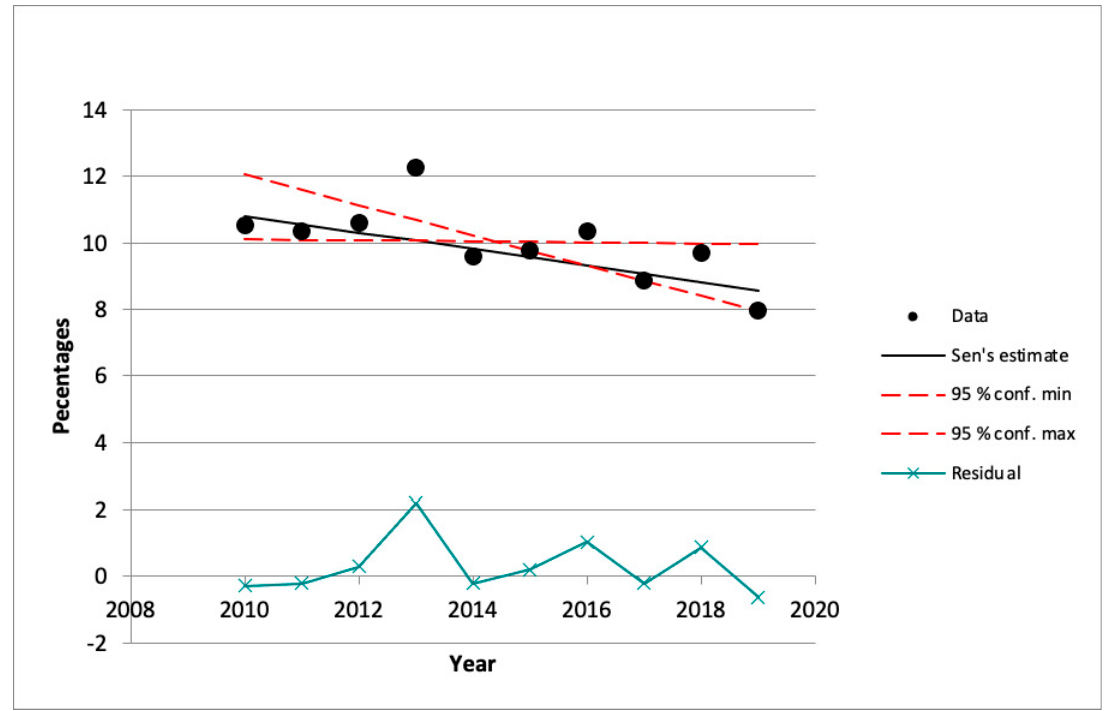
Figure 1. Changes in Italian femicides cases over time.